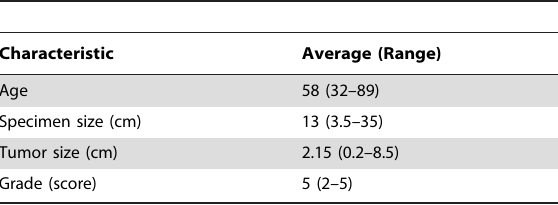
Table 1. Average ranges of clinicalpathological characteristics of 67 patients diagnosed with Breast Cancer.